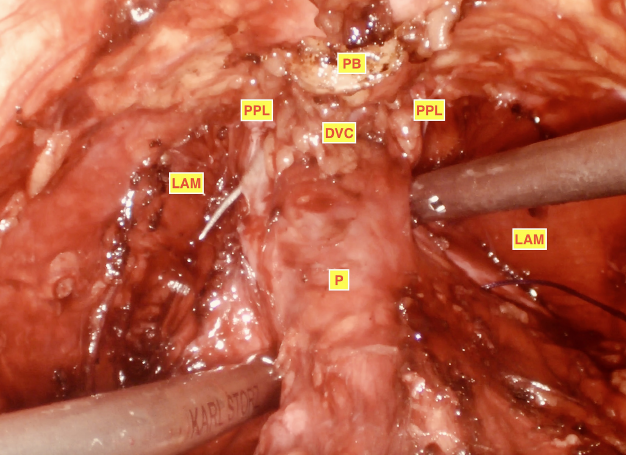
Figure 2. Traditional technique. The levator ani muscle (LAM) is exposed after a bilateral incision to the endopelvic fascia. The dorsal vascular complex (DVC) is ligated. The puboprostatic ligaments (PPL) are transected. P, prostate; PB, pubic